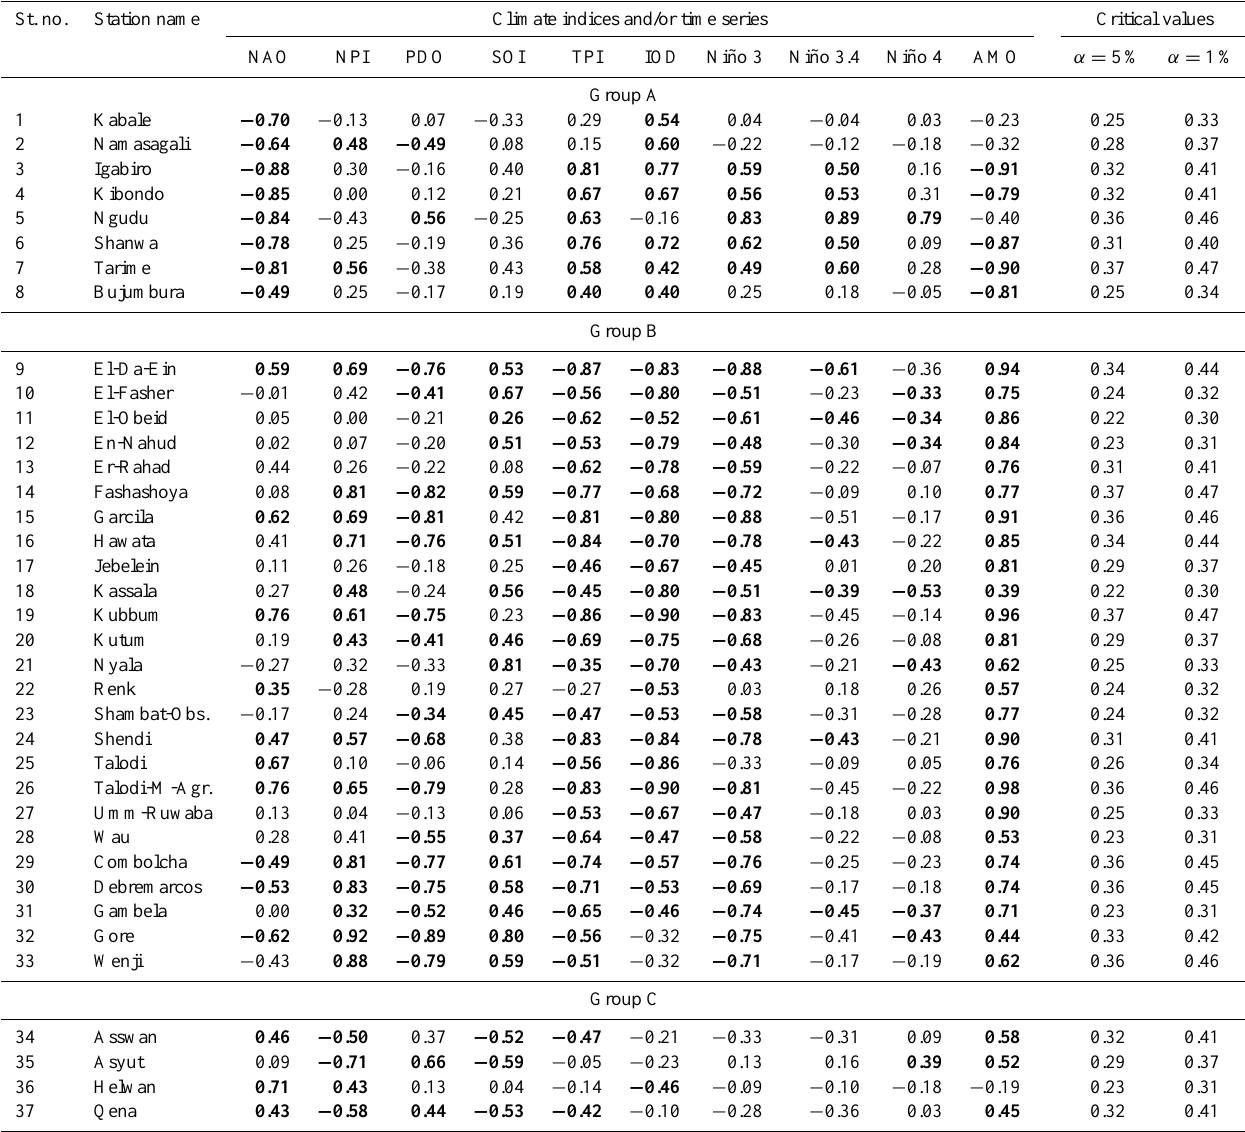
Table 4. Correlation between QPM results for annual rainfall and climate indices over the periods 1935–1970 (for group A), 1954–1992 (for group B) and 1945–1985 (for group